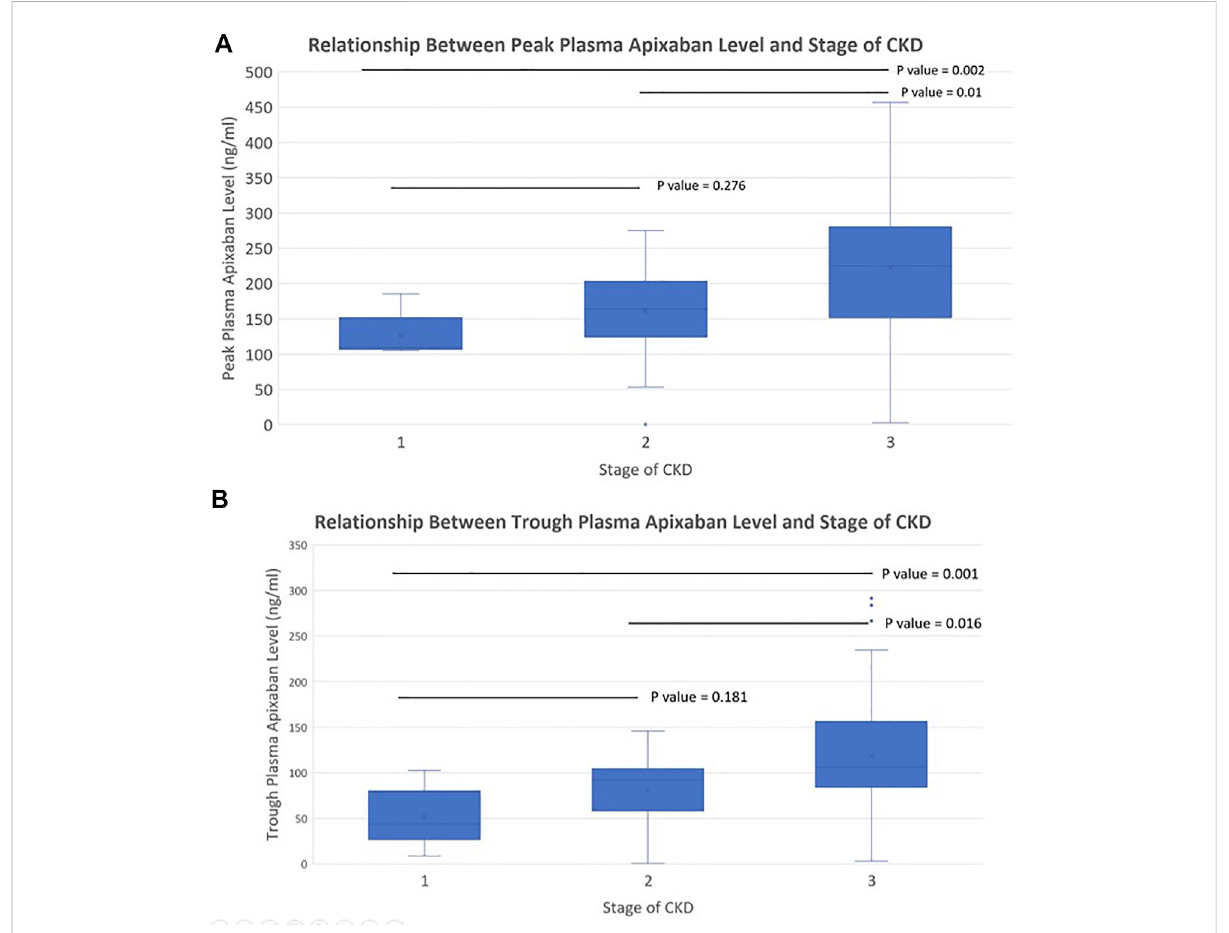
FIGURE 2 (A) RelationshipbetweenpeakplasmaapixabanlevelandstagesofCKD(apixaban5 mgtwicedaily).Differenceofpeakplasmaapixabanlevelin patients with different stages ofCKD. The peaklevel of stage 3vs. stage 2 vs. stage 1 CKD patients was 223.4 ± 107.8 ng/ml vs. 161.0 ± 55.2 ng/ml vs. 126.6 ± 30.2 ng/ml, overall p -value < 0.05; Difference between stage 3 CKD vs. stage 2 CKD, stage 3 CKD vs. stage 1 CKD, stage 2 CKD vs. stage 1 CKD: p = 0.01 vs. 0.002 vs. 0.276). (B) Relationship between trough plasma apixaban level and stages of CKD (apixaban 5 mg twice daily).